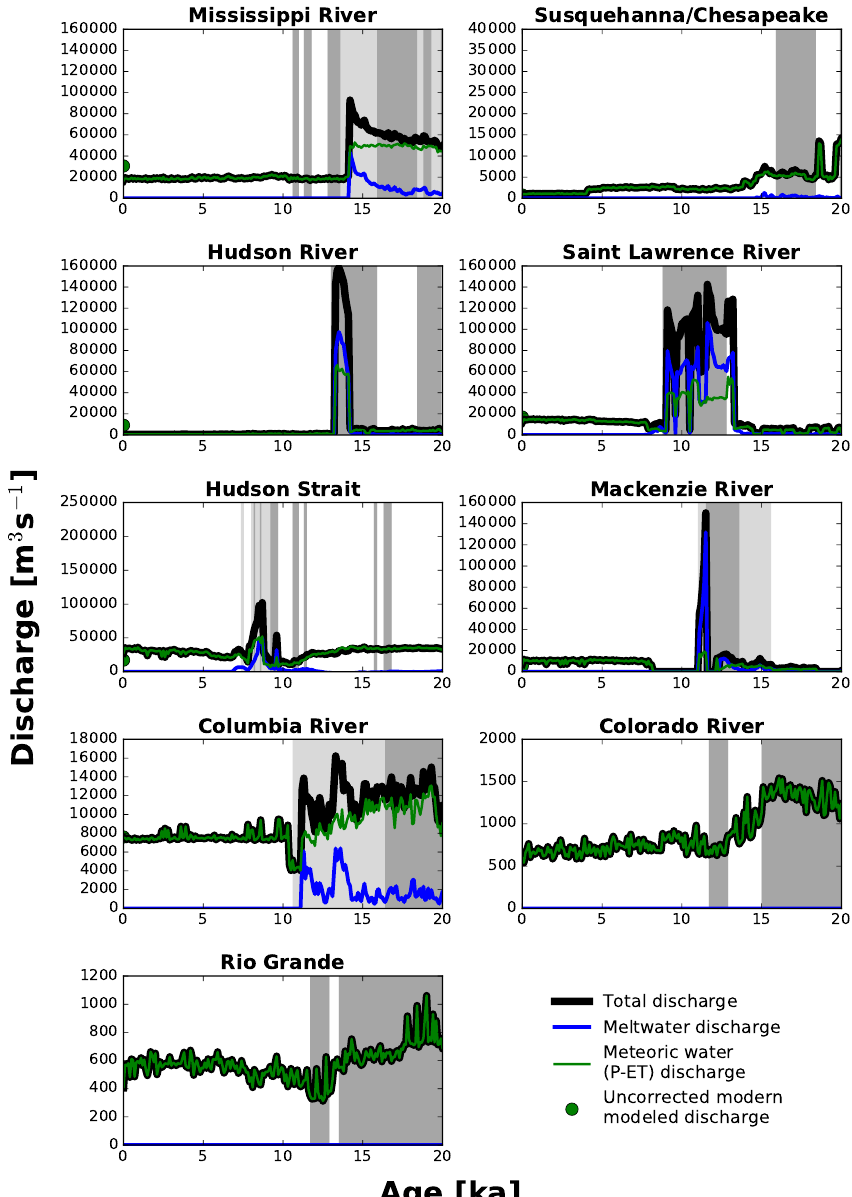
Figure 14. Computed discharge based on the G12/VM2 coupled ice-sheet–solid-Earth model (Gregoire et al., 2012; Peltier, 2004), compared to the geologic record of enhanced past discharge (gray shading: dark, direct record; light, inferred and/or less-enhanced discharge). Notes on the geologic record can be found in Fig.